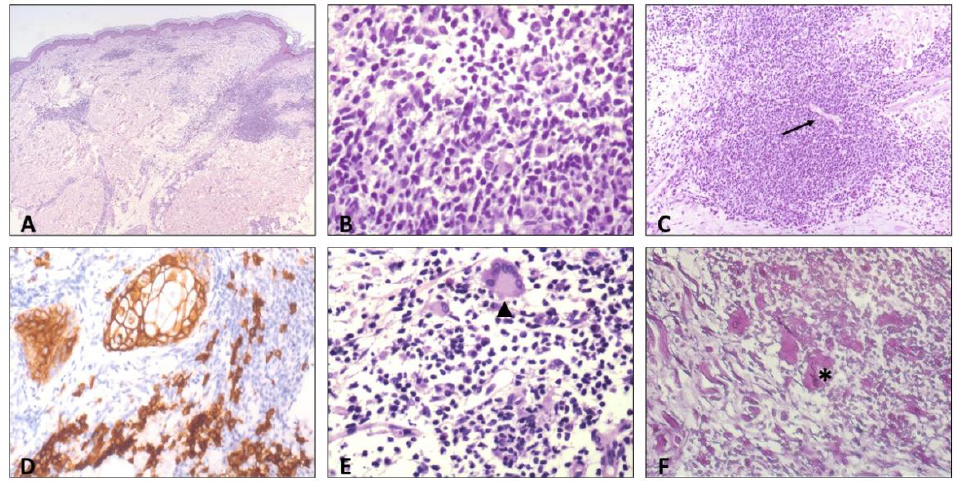
Figure 3. Histologic findings: ( A ) superficial and deep dermal perivascular inflammatory infiltrate, hematoxylin eosin (HE). ( B ) High-power view of the inflammatory infiltrate, showing predominance of lymphocytes and plasma cells, HE. ( C ) Endothelial swelling of dermal blood vessels (arrow), HE. ( D ) Immunostaining for CD138 highlights plasma cells infiltrate, ( E ) scattered multinucleated giant cells in the infiltrate, also of the Langhans type (arrowhead), and ( F ) elastophagocytosis (asterisk), Weigert-Von Gieson staining.